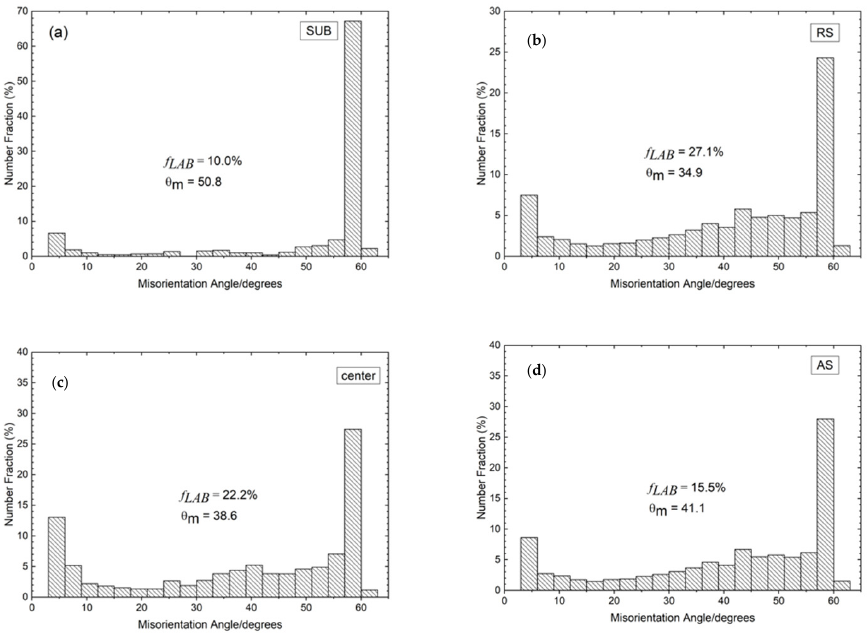
Figure 5. Misorientation angle histogram for γ / γ boundaries: ( a ) SUB, ( b ) RS, ( c ) center, and ( d ) AS ( f LAB : fraction of low-angle boundaries, θ m : mean misorientation angle).